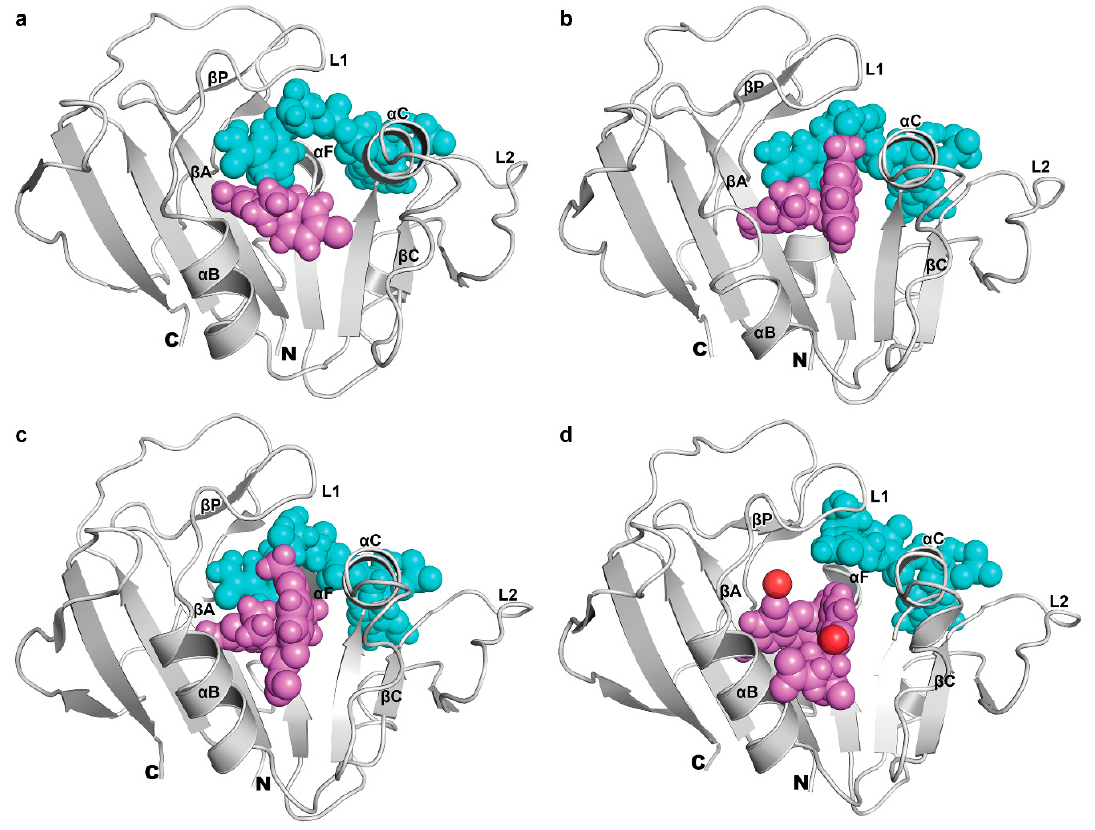
Figure 6. NADPH (blue) and ligand (pink) binding sites on mtbDHFR (gray ribbon) for MD simulations at 16 ns: ( a ) P1; ( b ) P157; ( c ) P169 and ( d ) DHF. Two water molecules (red spheres) are found in the substrate DHF binding site.